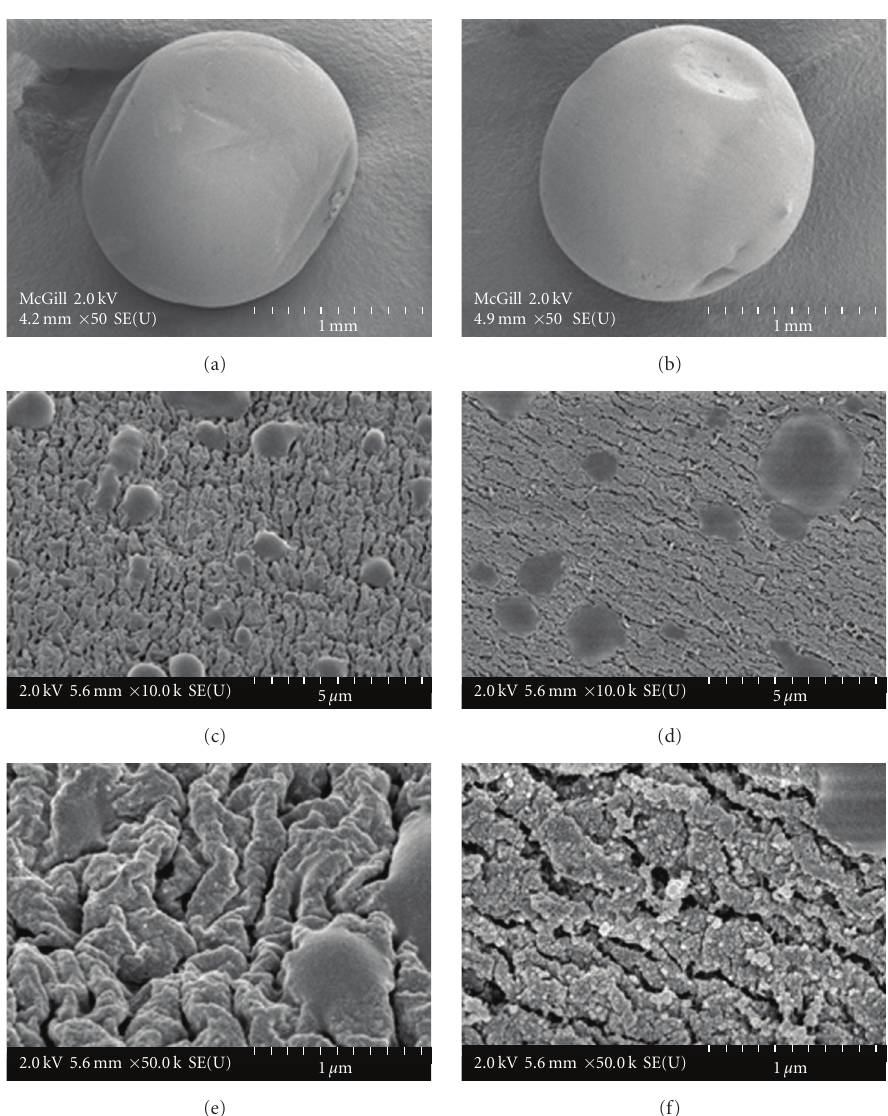
Figure 1: SEM images of the AC (a), (c), (e) and GCAC (b), (d), (f) microcapsules. (a)-(b): overview at 50 × ; (c)-(d) and (e)-(f): surface structure at 10kx and 50 kx,